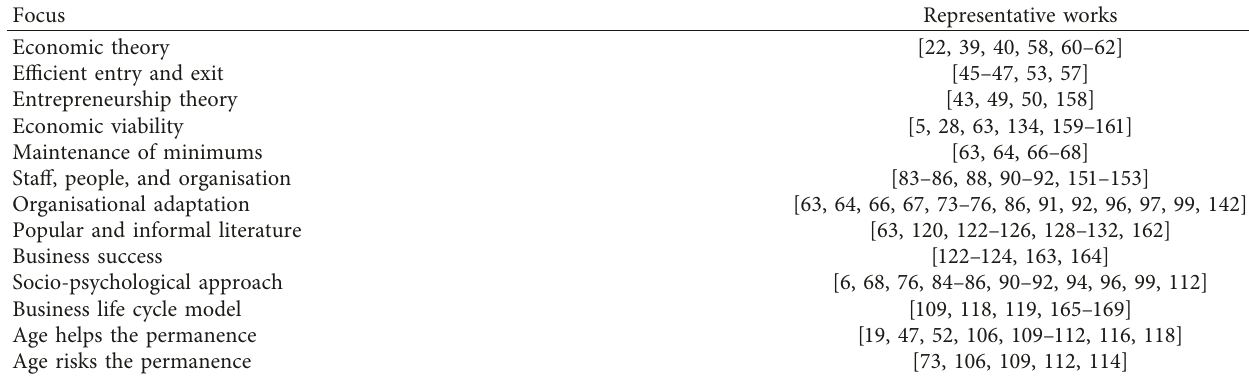
Table 1: Summary of visited references and representatives works in each